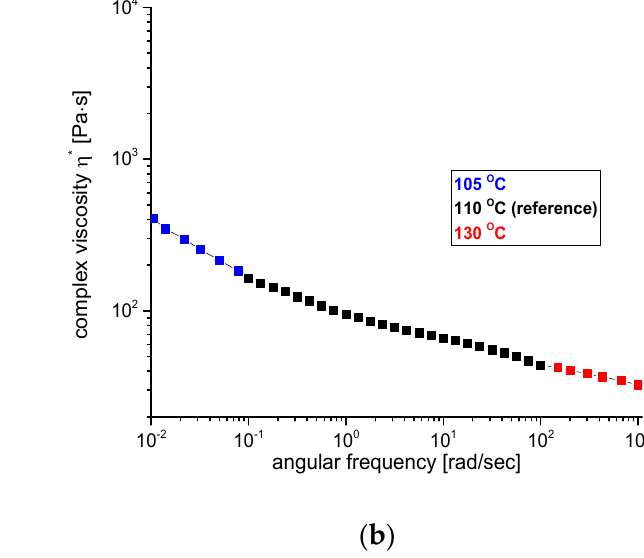
Figure 6. ( a ) Loss (rectangles) and storage (circles) moduli and ( b ) complex viscosity values. Time- temperature superposition was applied to a temperature range from 100 to 150 °C.